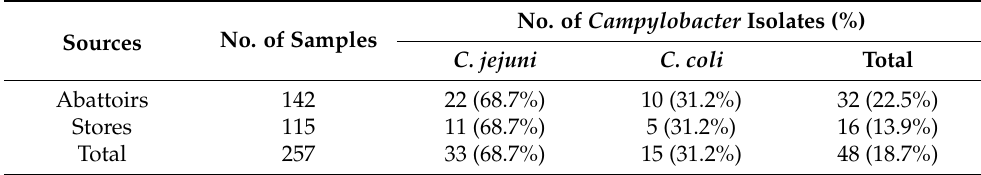
Table 1. Isolation rates of thermotolerant Campylobacter strains from chicken carcasses.